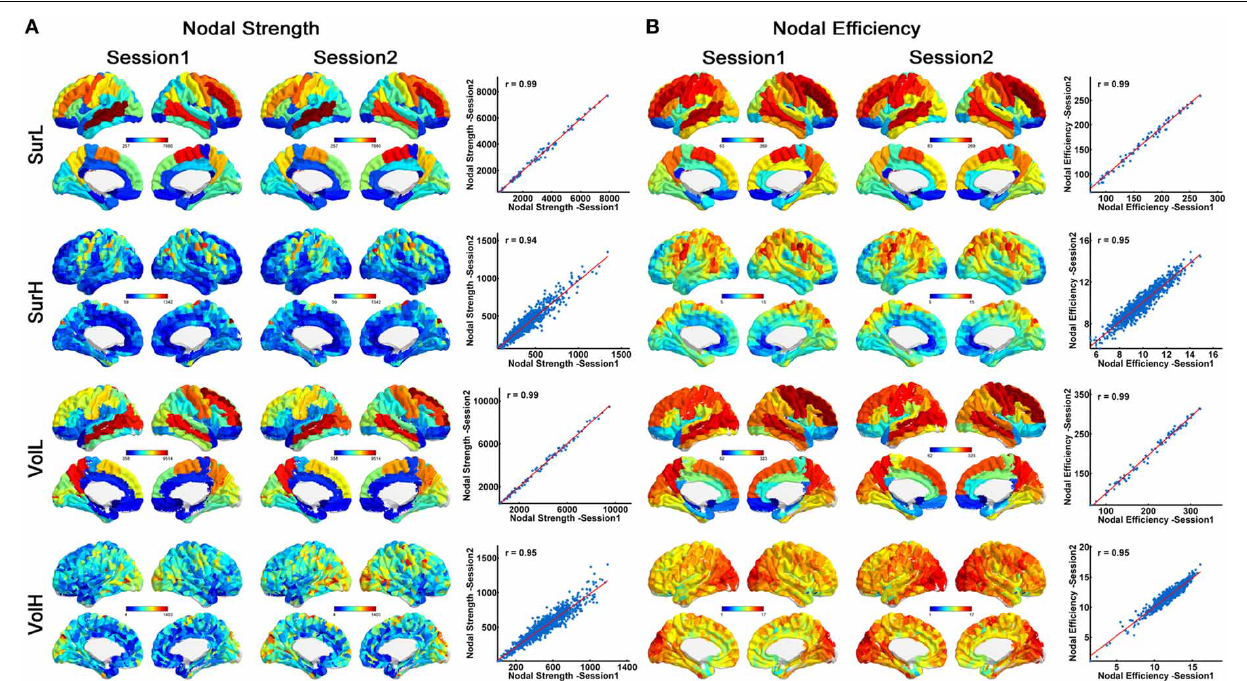
FIGURE 3 | The correlation of nodal properties between sessions. (A) Similar spatial patterns of nodal strength across regions and high correlation of nodal strength between two sessions are demonstrated. On the 3D surface, the nodes with strengths from low to high are represented with colors from blue to red. In the plot, the blue dots represent nodal strength and are linearly fitted with a red line between